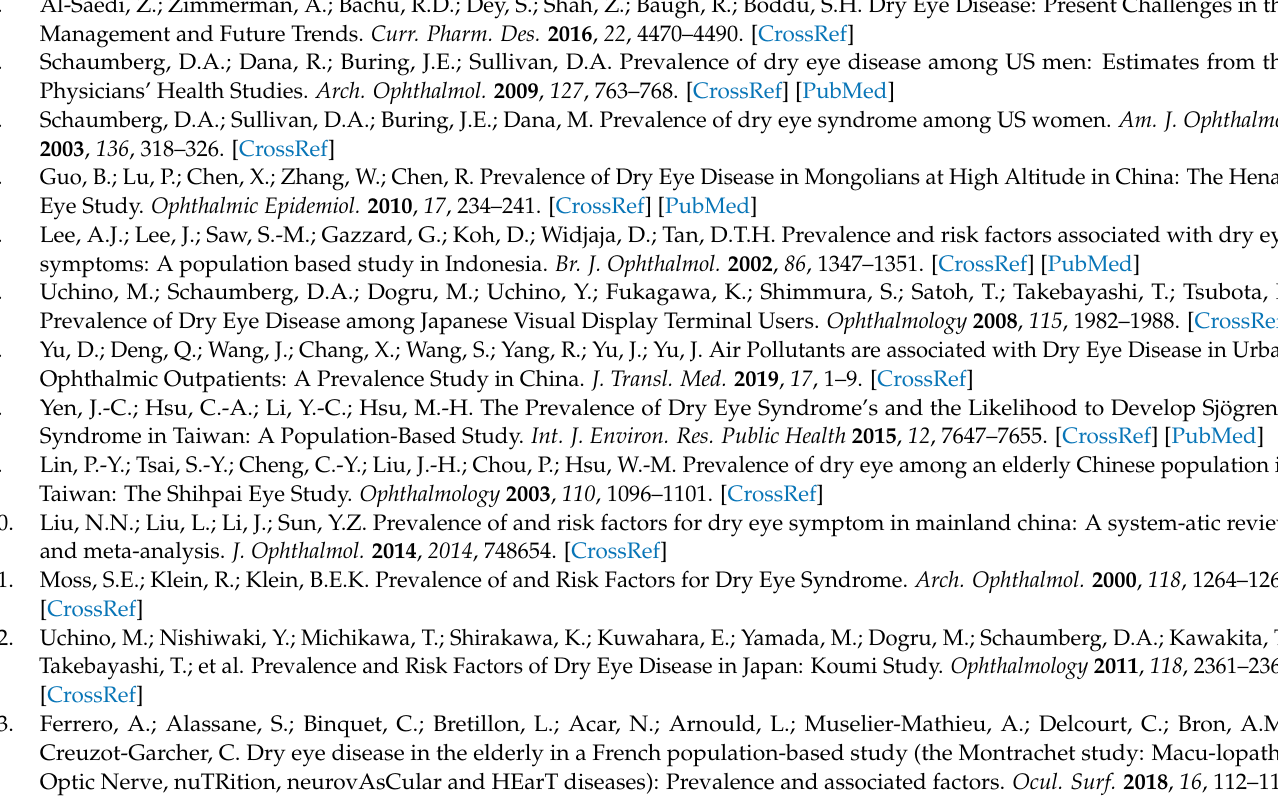
participants. Table S2: Sensitivity analysis for the effects of various air pollutants on the risk of dry eye syndrome 1 year, 3 years, or 5 years exposure duration of air pollutants before the survey